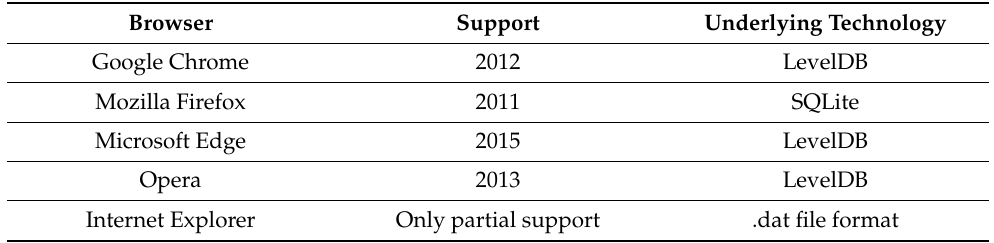
Table 2. IndexedDB Support and Technology in Web Browsers. Browser Support Underlying